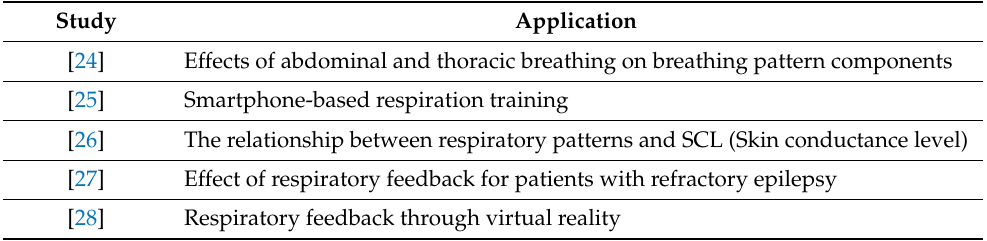
Table 1. Prior studies using respiratory